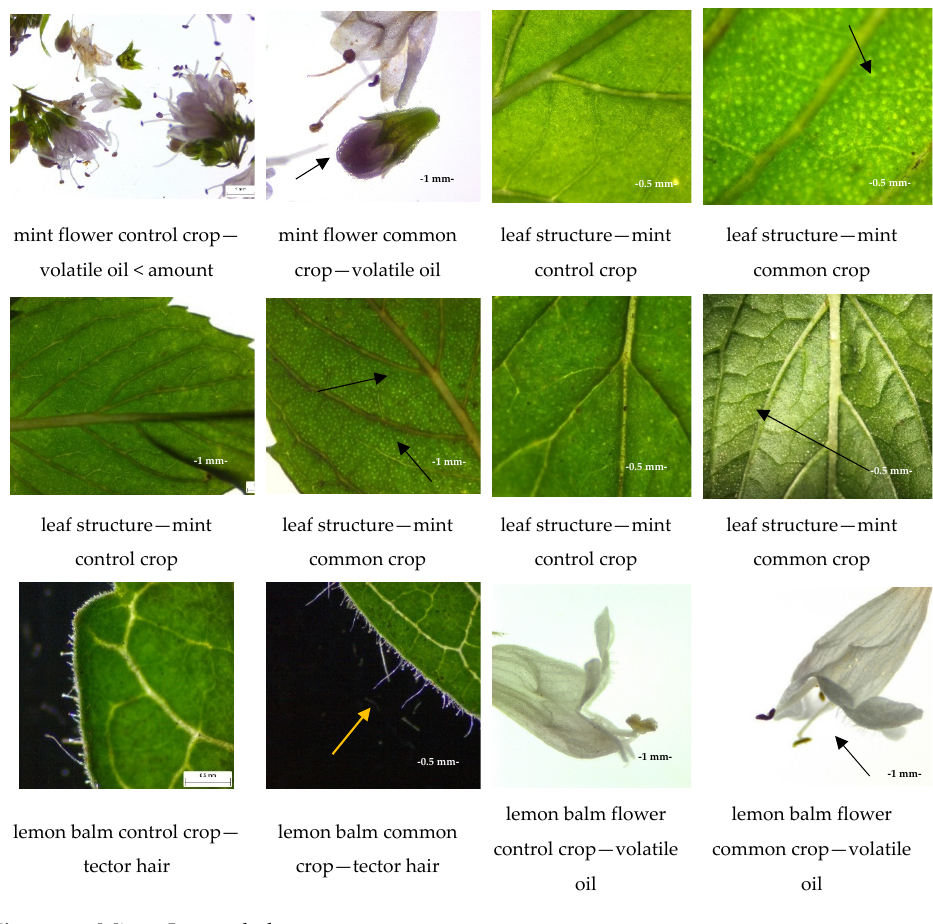
Figure 10. Mint—Lemon balm. In the thyme leaves and flowers grown in a common crop with marigolds, a higher density of glandular bristles can be observed, which would imply a higher secretion of volatile oil. In the marigold flowers from the common sample, an abundance of cells con- taining stratified pigment are found, possibly tetraterpenic derivatives of a carotenoid type (Figure 11) [28].